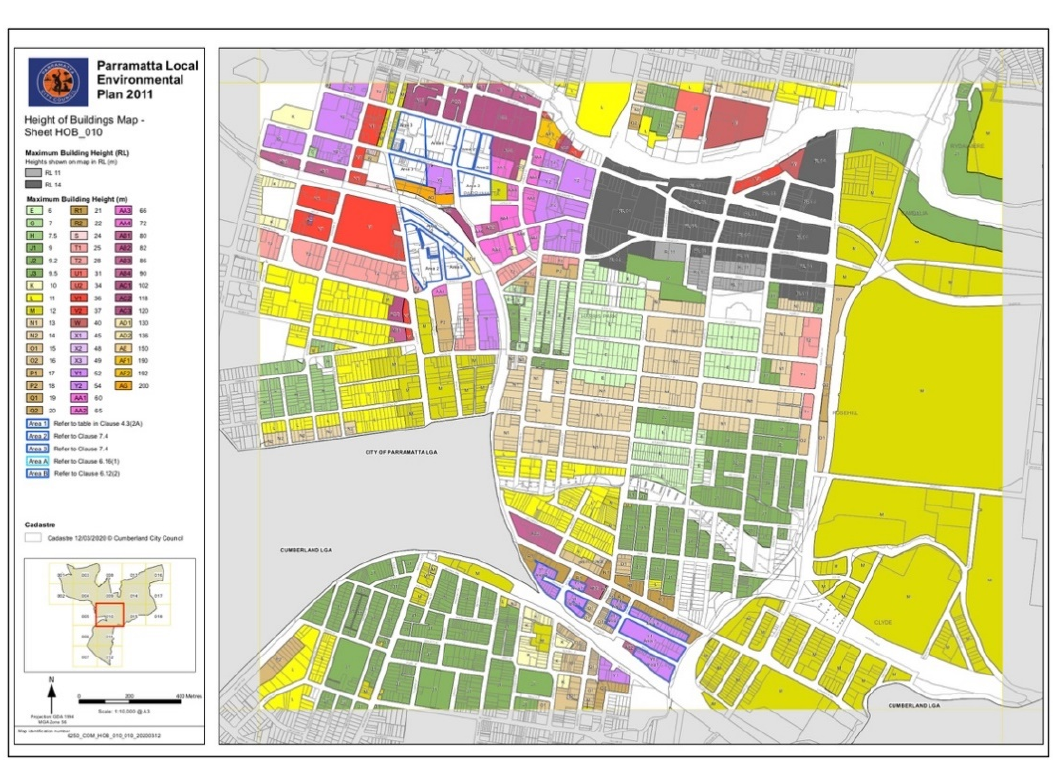
Figure A7. Parramatta Height of Building LEP.